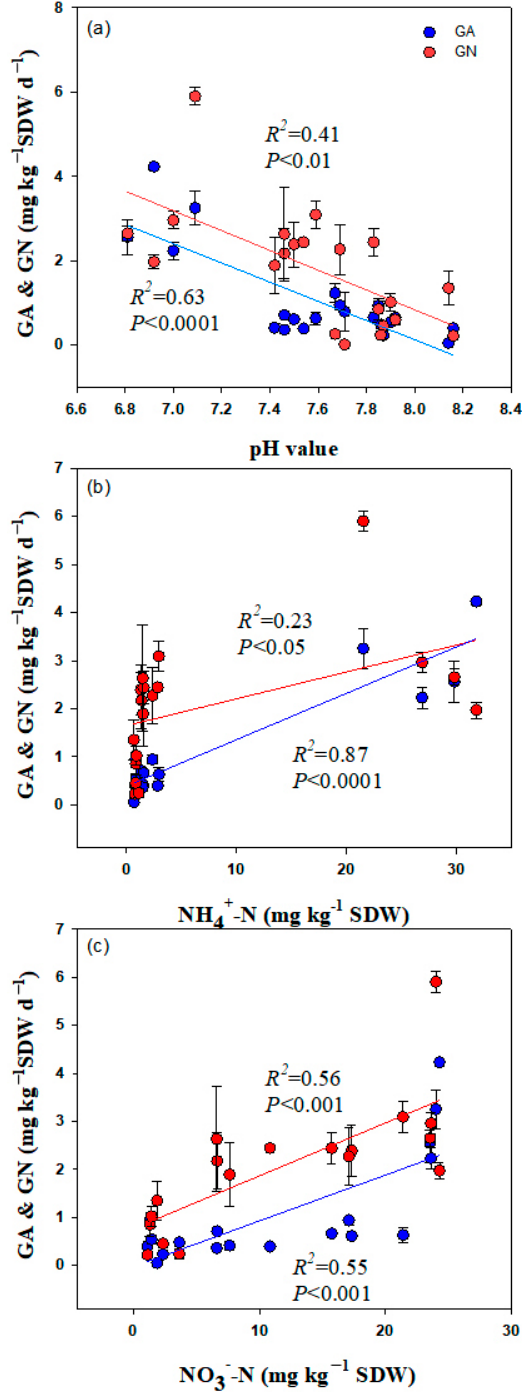
Figure 3. Relationships of gross ammonification rate (GA) and gross nitrification rate (GN) with pH values ( a ), NH 4+ -N ( b ), NO 3 − -N ( c ).